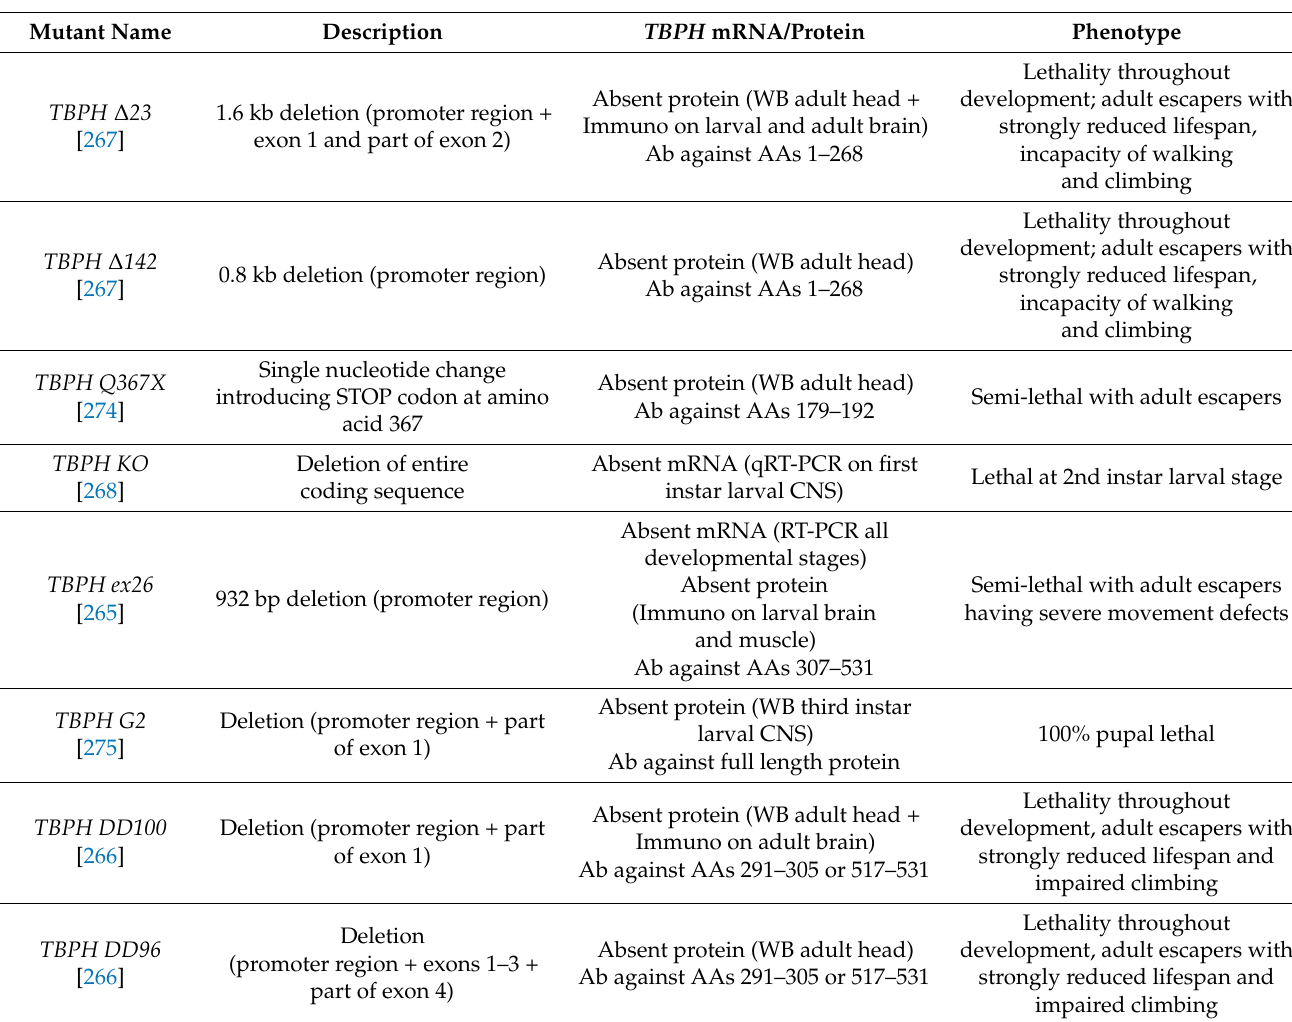
Table 6. TDP-43 homolog ( TBPH ) mutants cited in this review. mRNA, messenger